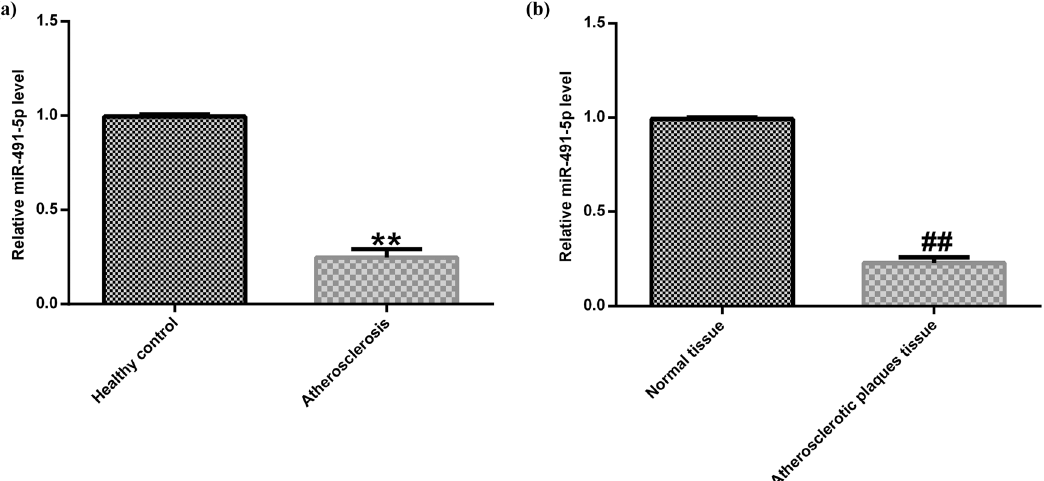
Figure 1: Low expression of miR - 491 - 5p in atherosclerotic tissues and plasma. ( a ) Expression of miR - 491 - 5p in the plasma samples of 30 patients with atherosclerosis and 30 controls was determined by qRT - PCR. ( b ) Expression of miR - 491 - 5p in the atherosclerotic plaque tissues of 30 patients with atherosclerosis and 30 controls was detected by qRT - PCR. The data are expressed as mean ± SD; ** p < 0.01 vs. healthy control; ## p < 0.01 vs. normal